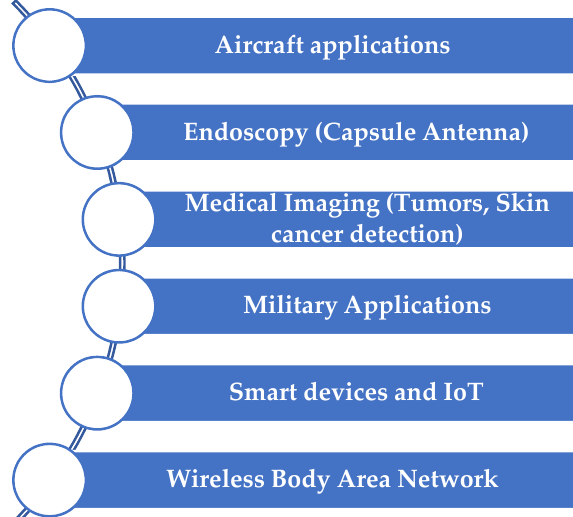
Figure 2. Applications of a flexible antenna.